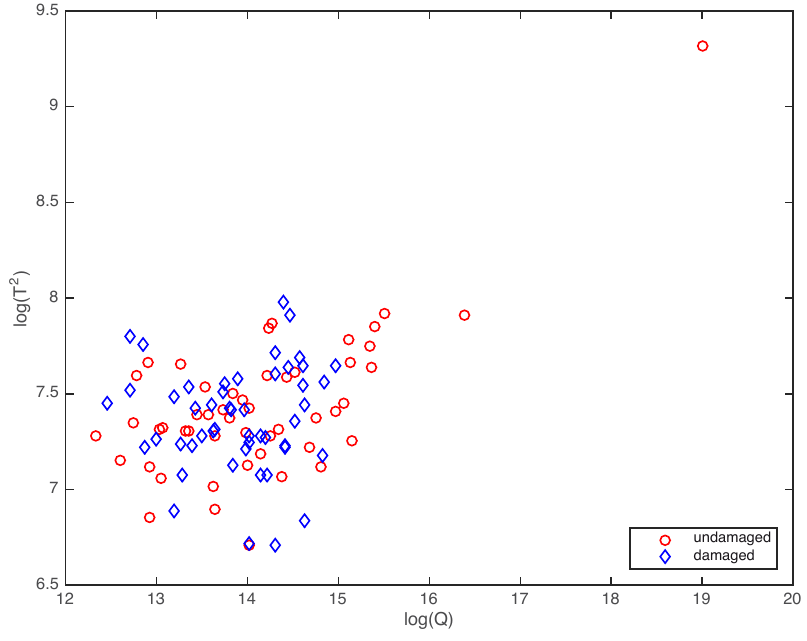
Figure 5. Natural logarithm of indices Q and T 2 of samples coming from the healthy wind turbine (red, circle) and from the faulty wind turbine (blue,